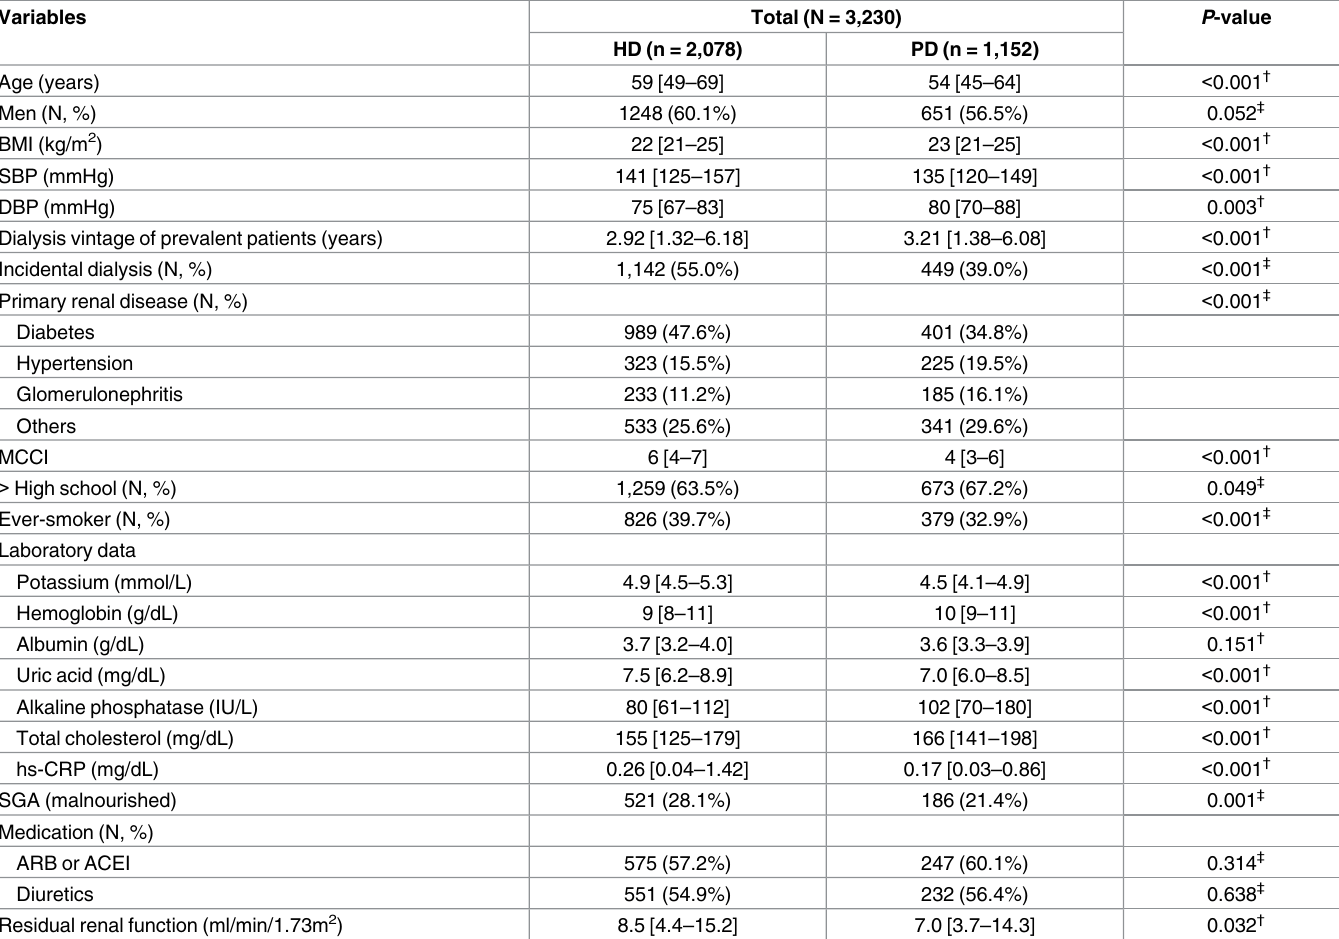
Table 1. Demographic and clinical characteristics of end-stage renal disease patients according to dialysis